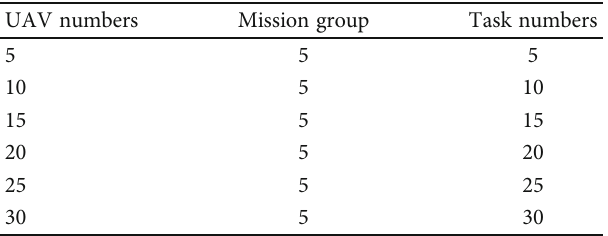
Table 6: The number of UAVs and task